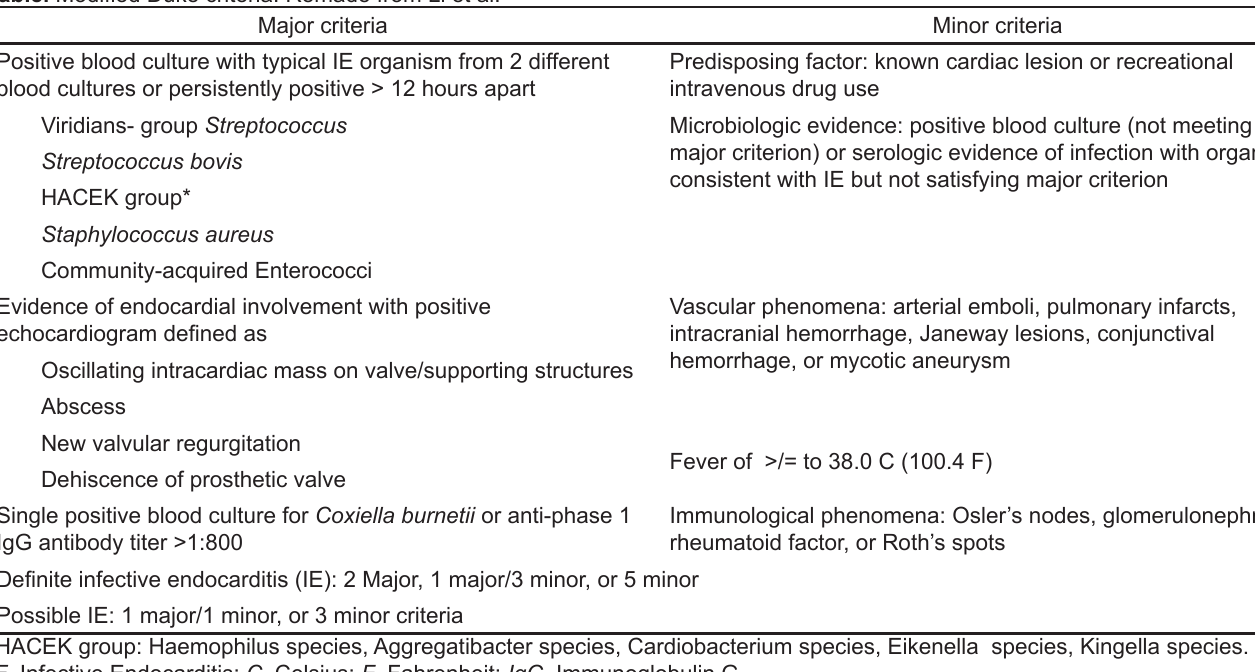
Table. Modified Duke criteria. Remade from Li et al.